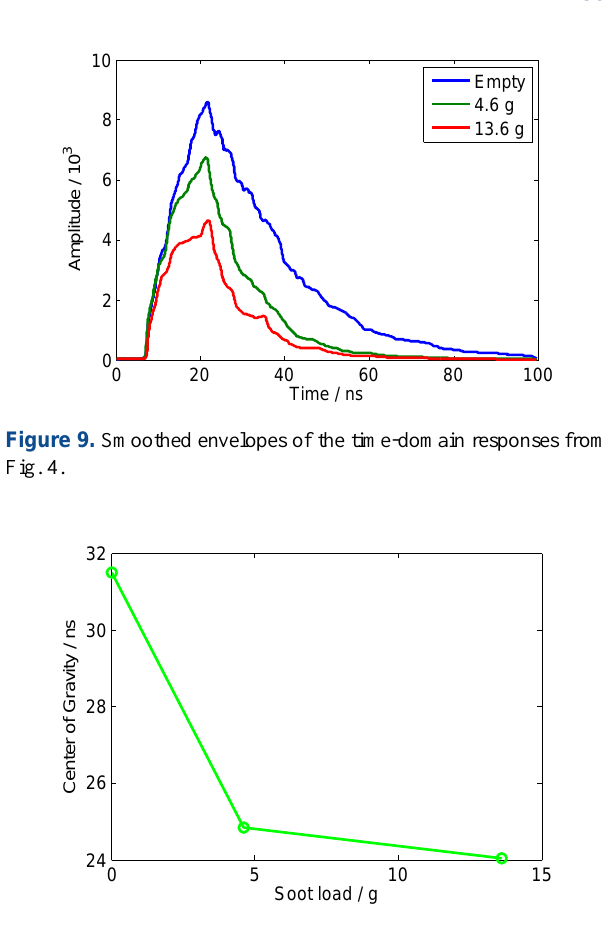
Figure 10. Time coordinate of the center of gravity of the area bounded by the smoothed envelopes and the time axis in Fig.